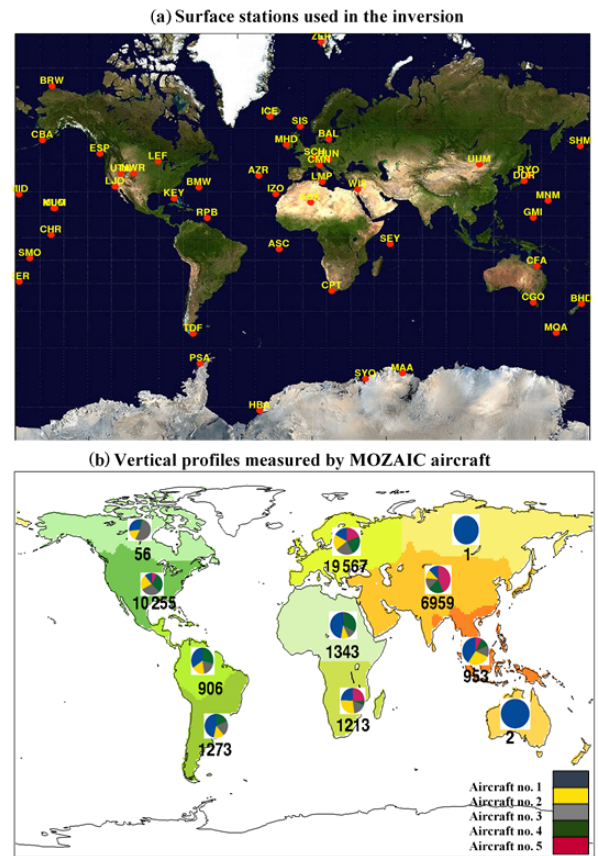
Figure 2. (a) Map showing the locations of the stations of the surface-based measurements used in the Jena inversion